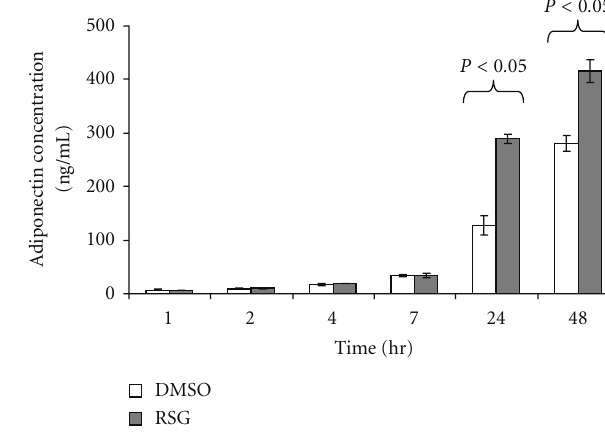
Figure 6: RSG induced adiponectin release from 3T3-L1 adipocytes. Cell culture medium was collected at indicated time points, and adiponectin concentration was measured ( n = 4 each condition at each time point). All numerical data were expressed as mean ± SE. The experiment was repeated at least